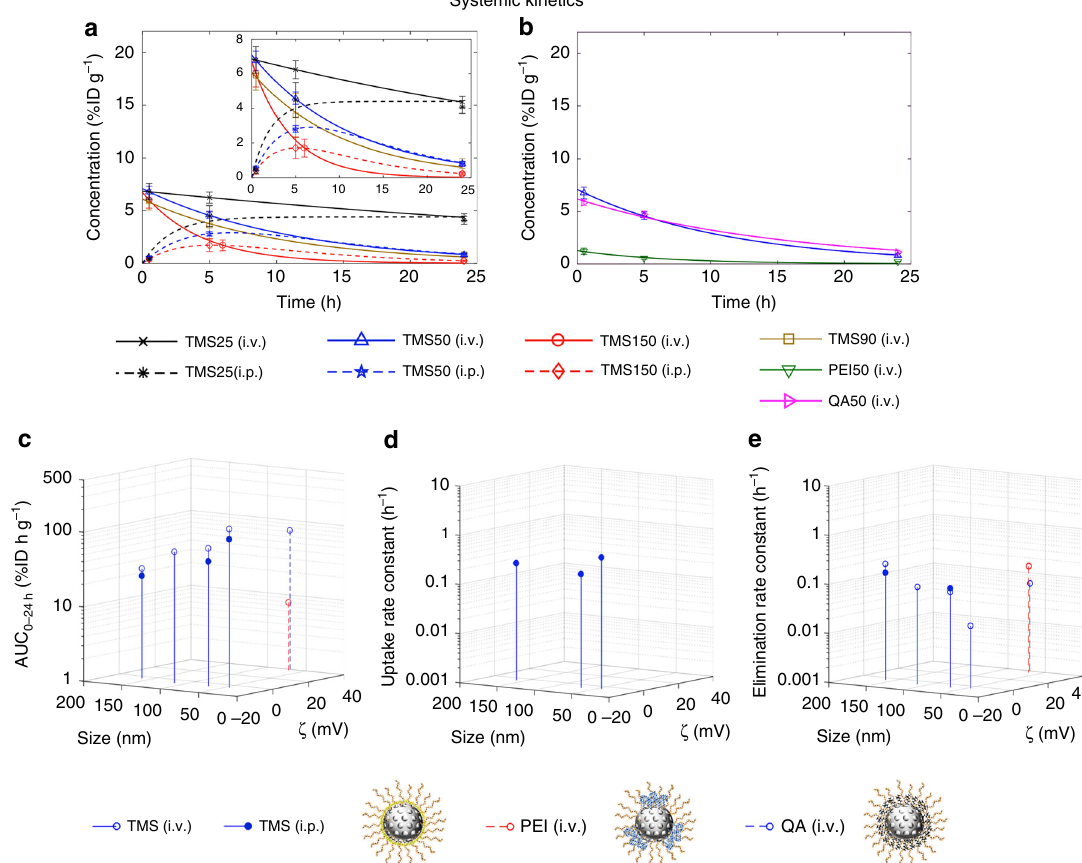
Fig. 4 Systemic kinetics. a , b One-compartment PK model (Eq. (6) for i.v. and Eq. (4) for i.p.) was fi t to the concentration – time data for different MSNs in the heart ROI (Supplementary Tables 4 and 5). Fitted concentration – time curves demonstrate the effect of MSN size and route of administration for TMS- modi fi ed MSNs ( a ) and surface chemistry and zeta potential for 50 nm diameter MSNs modi fi ed with TMS, QA, or PEI ( b ). The inset in a is a rescaled version of the fi gure for a clearer view. Solid lines, i.v. cases; dotted lines, i.p. cases. c – e 3-D stem plots show area under the concentration – time curves (AUC 0 – 24h ) ( c ) and model parameter estimates (( d ) uptake rate constant, k in , and ( e ) elimination rate constant, k out ), obtained for different MSNs from a , b , in multiparameter space. Data represent mean ± s.d., n = 4 (except TMS50 (i.p.) and TMS25 (i.p.), where n = 3)